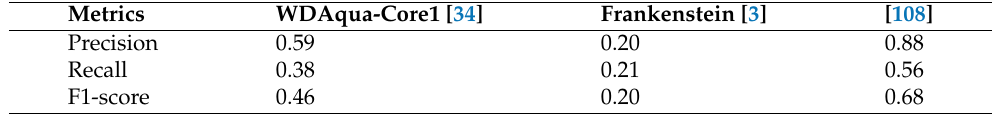
Table 5. Performance evaluation on the LC-QuAD dataset.